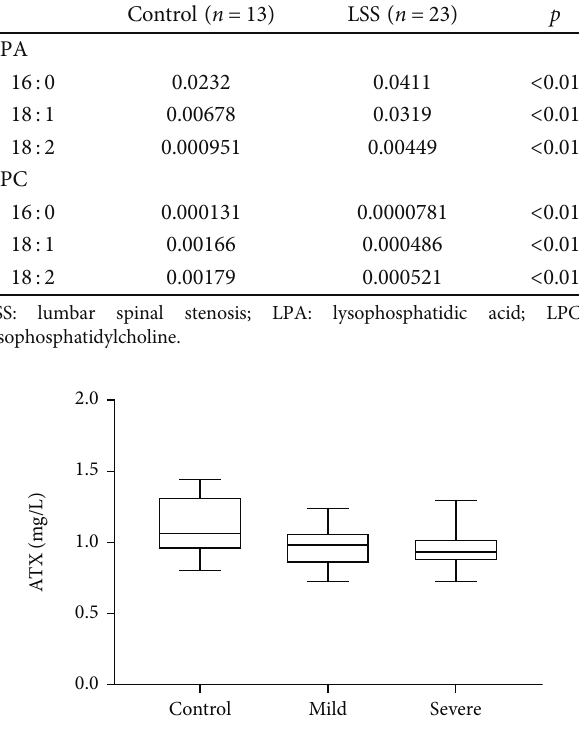
Figure 1: High expression of LPA and LPC in CFS of LSS patients. ATX levels in CSF between the severe group, mild group, and control group in the LSS.